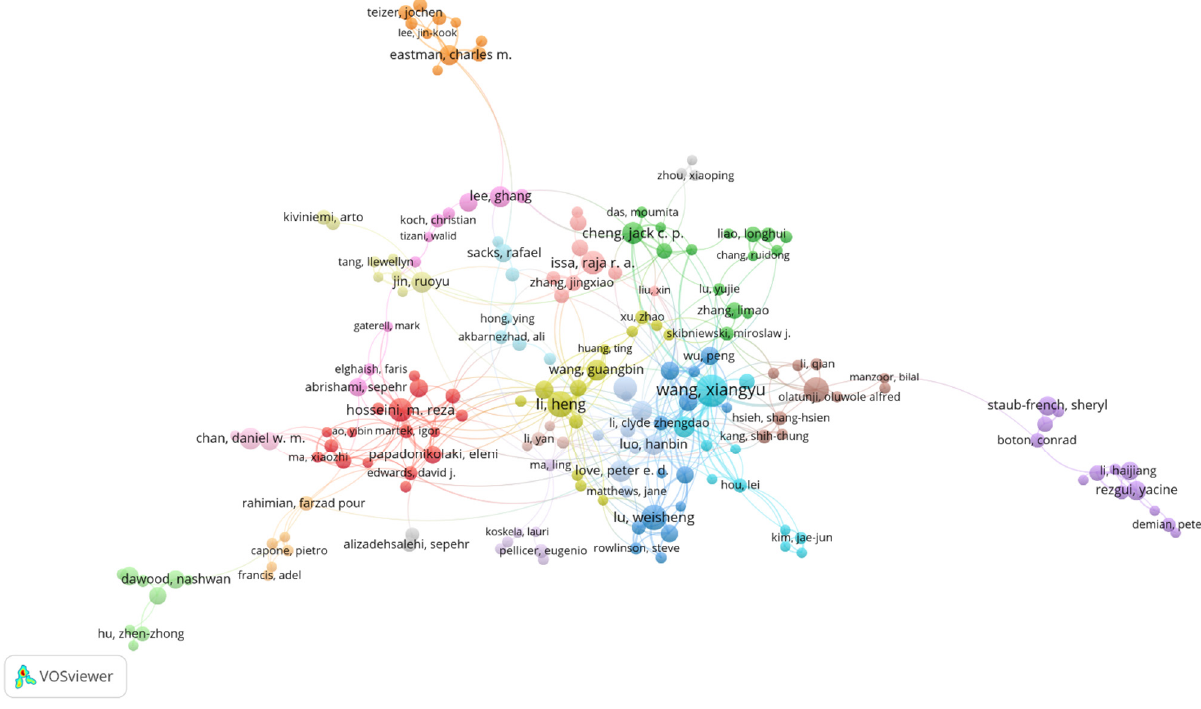
Figure 10. Network visualization of co-authorship network.